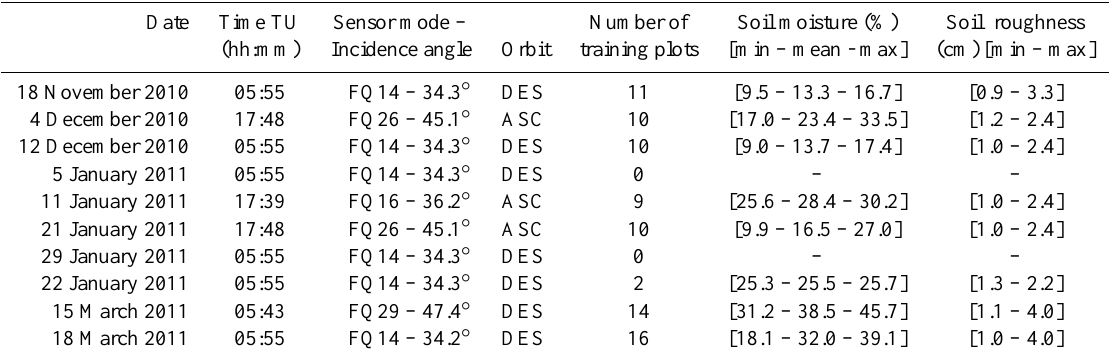
Table 1. Characteristics of the data set used in this study: images characteristics, number of training plots, range of soil moisture, and soil surface roughness